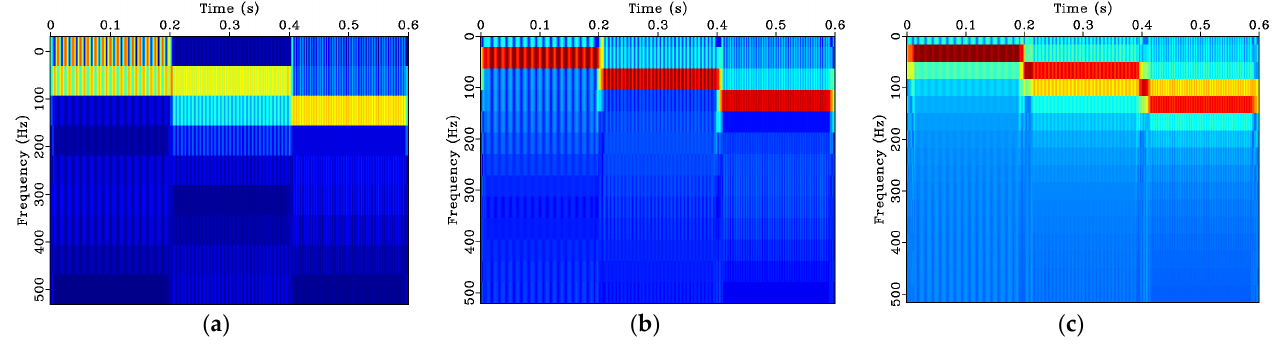
Figure 4. STFT time-frequency spectra with different time window lengths: ( a ) 13; ( b ) 21; and ( c ) 29 points. The jet colormap is used where blue and red represent low and high frequency magnitudes, respectively.